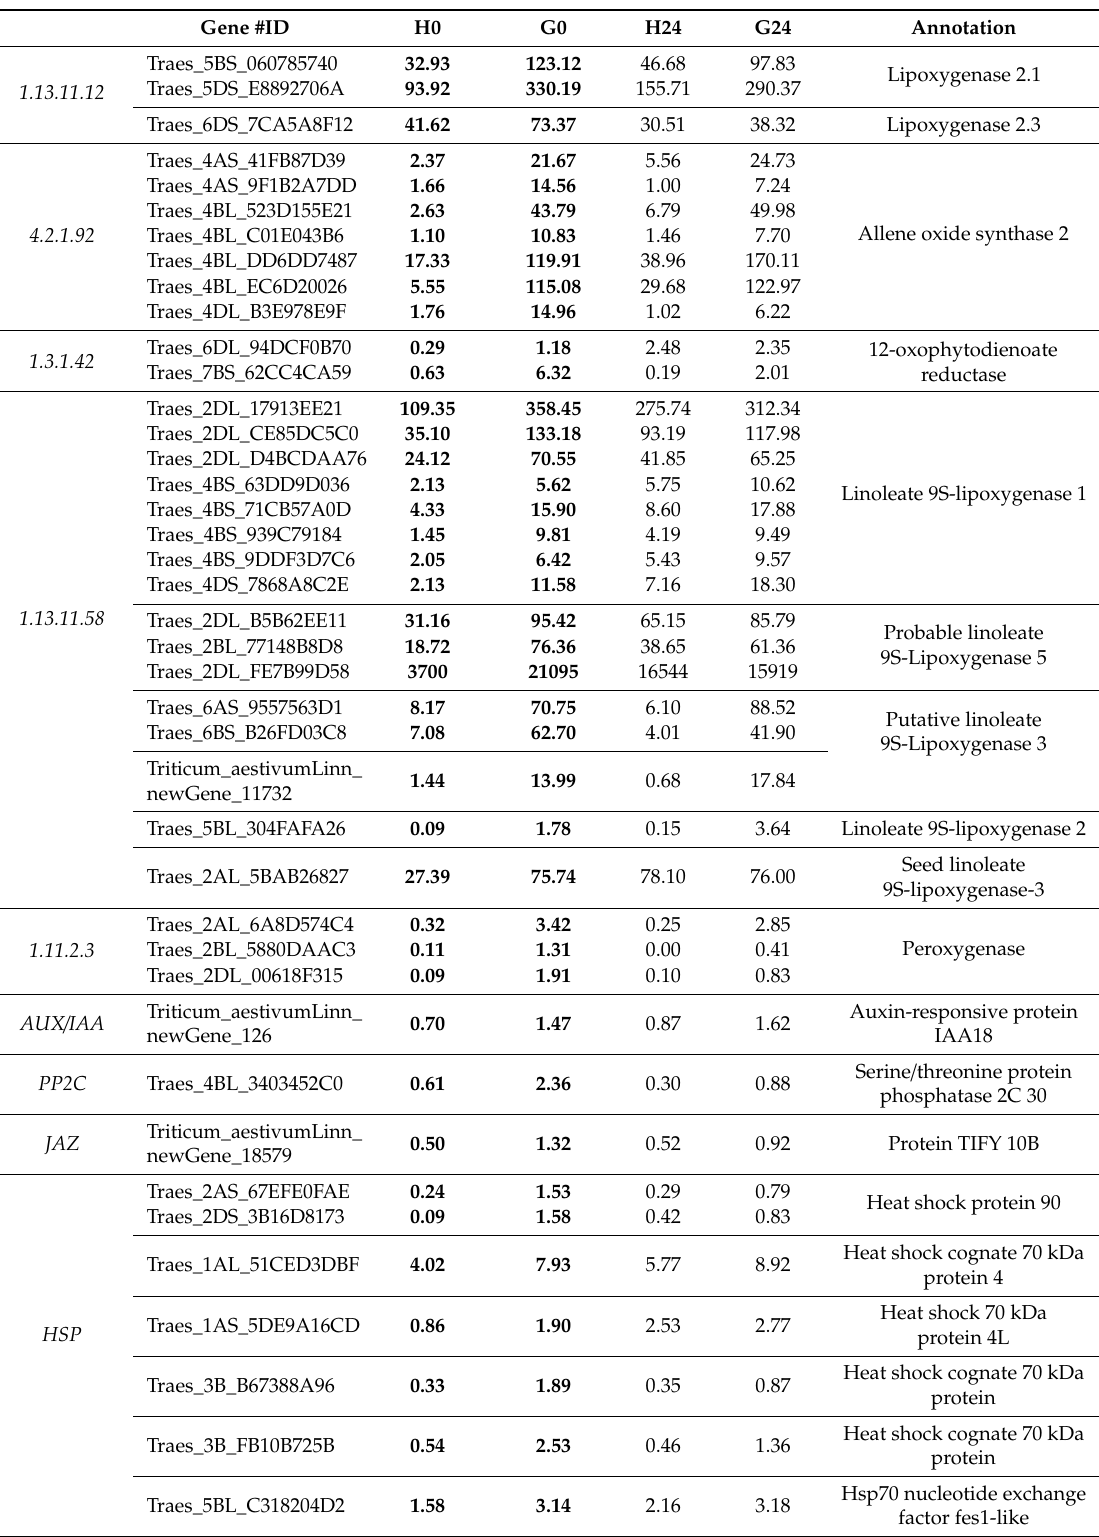
Table 2. DEGs in the G0 vs. H0